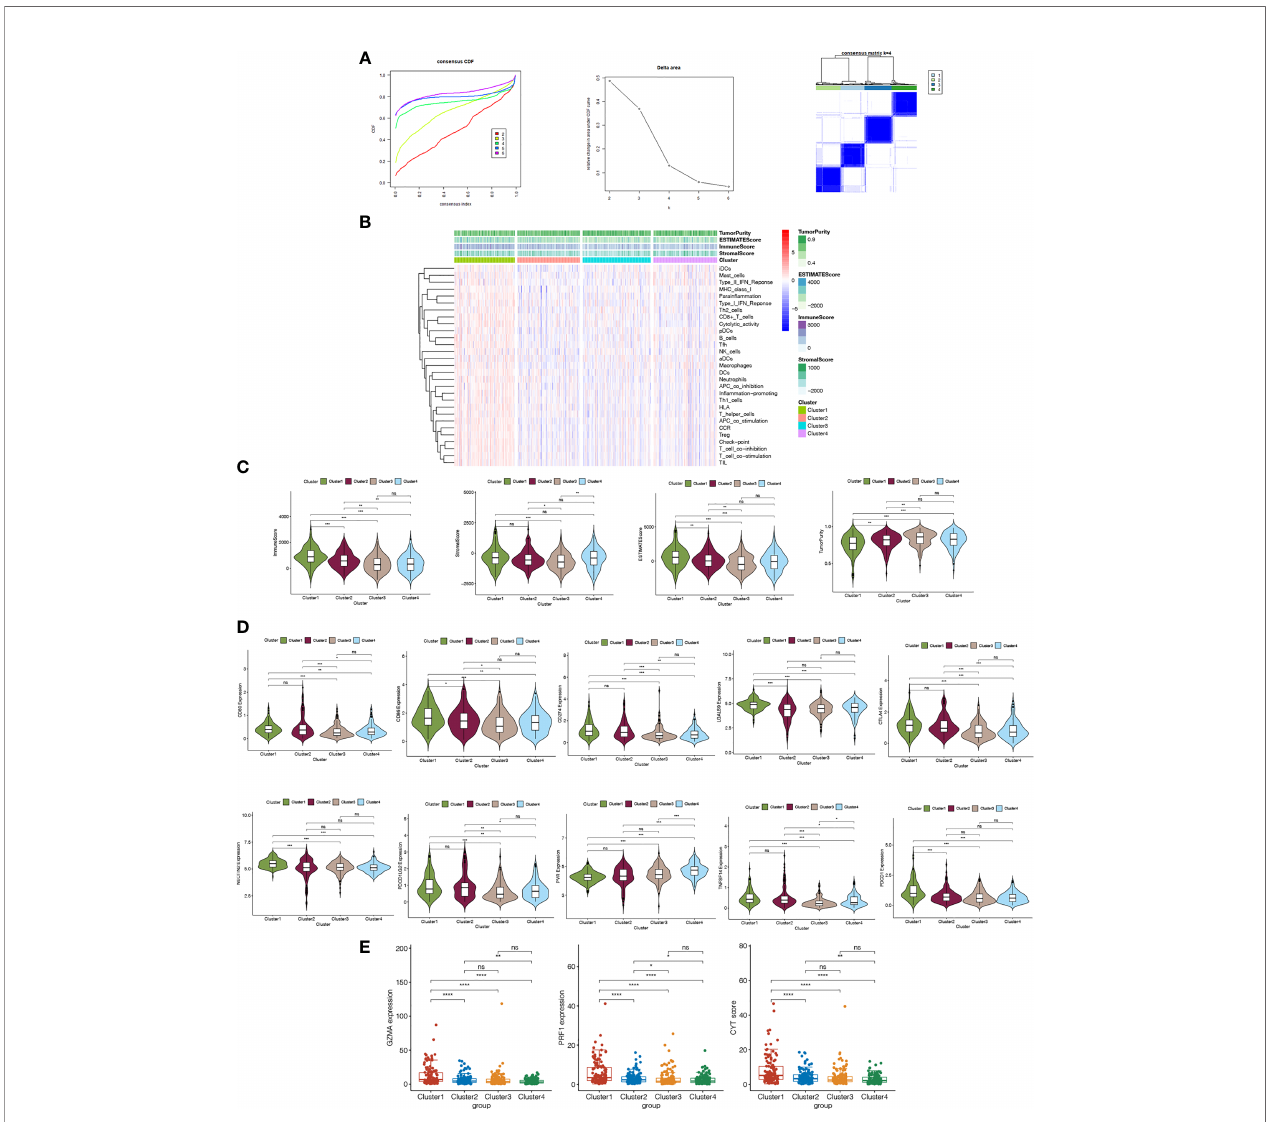
FIGURE 2 | (A) Consensus clustering CDF of k=2 to 6; Delta area under the CDF curve; Consensus clustering matrix of k=4. (B) Heatmap illustrating the relationships of four clusters and different immnue features (C) Immune, stromal, estimate scores and tumor purity using ESTIMATE (D) The expression of immune checkpoint genes in different clusters (E) The correlations of GZMA, PRFI gene expressions and CYT scores with